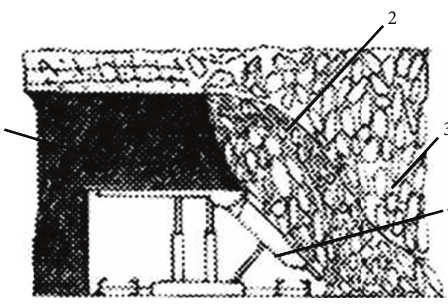
Figure 1: Hydraulic support and installation position of sensors (1: coal, 2: coal-gangue, 3: gangue, and 4: